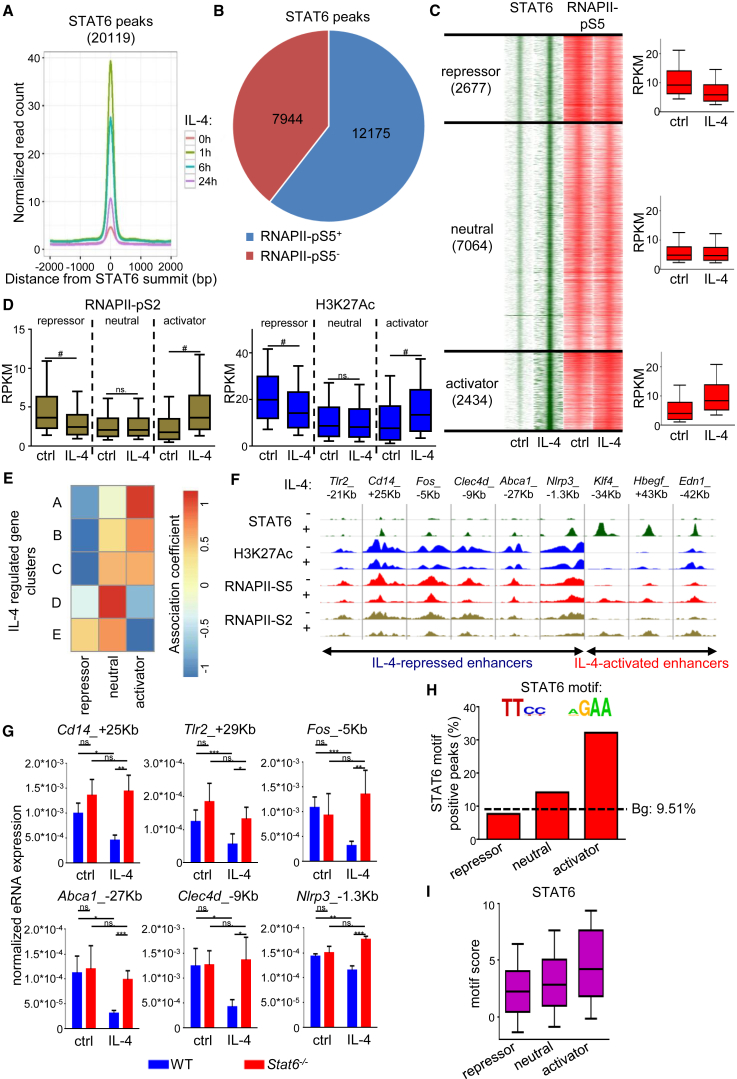
RNAPII-pS5-Based Characterization of IL-4-Activated STAT6 Cistrome in Mouse Macrophages(A) Histograms of the average coverage of STAT6 peaks at the indicated period of time following IL-4 treatment in WT BMDMs.(B) Pie chart of the RNAPII-pS5-positive and -negative STAT6-bound regulatory regions, 1 hr of IL-4 stimulation.(C) Read distribution plot of ChIP-seq intensities for STAT6 and RNAPII-pS5 around the summit of the detected STAT6 peaks in a 4 kb window (left). Clustering of STAT6-RNAPII-pS5 co-bound genomic regions was based on the usage of DiffBind analysis (p ≤ 0.05). Boxplots of the average RPKM values for RNAPII-pS5 in each cluster (right). Boxes encompass the 25th to 75th percentile RPKMs. Whiskers extend to the 10th and 90th percentiles.(D) Boxplots of RNAPII-pS2 and H3K27Ac read enrichments (RPKM) around the identified STAT6 peak clusters in WT BMDMs. Boxes encompass the 25th to 75th percentile RPKMs. Whiskers extend to the 10th and 90th percentiles.(E) Heatmap of correlations between STAT6 peak (C) and IL-4-regulated gene clusters (Figure 1A) based on genomic proximity and functional chromatin domain prediction.(F) Integrative Genomics Viewer snapshots of STAT6, H3K27Ac, RNAPII-pS5, and RNAPII-pS2 ChIP-seq signals on a set of IL-4-repressed and activated genomic loci.(G) RT-qPCR measurements of eRNA expression at IL-4-repressed enhancers in WT and Stat6−/− macrophages.(H) Bar plots showing the percentage of the STAT6 motif-positive STAT6 peaks in the clusters on (C). The STAT6 binding motif was used for targeted search. Dashed line indicates background (Bg: 9.51%).(I) Boxplot of STAT6 motif scores at the functionally distinct STAT6 peak clusters. Boxes encompass the 25th to 75th percentile motif scores. Whiskers extend to the 10th and 90th percentiles.BMDMs (B–D, F, and G) were treated with IL-4 for 1 hr. Data in (A)–(D) are combined from two independent biological replicates. Changes in (D) were considered significant at p < 0.00001 using paired t test and an average fold change cut off value of ≥ 1.15 was used between control and IL-4-treated samples. # means significant difference, n.s. indicates not significant change. Data in (F) are representative of two independent biological replicates. Data in (G) are representative of five individual animals per genotype from two independent experiments. ∗p < 0.05, ∗∗p < 0.01, ∗∗∗p < 0.001, ns, not significant change. Error bars represent mean ± SD.